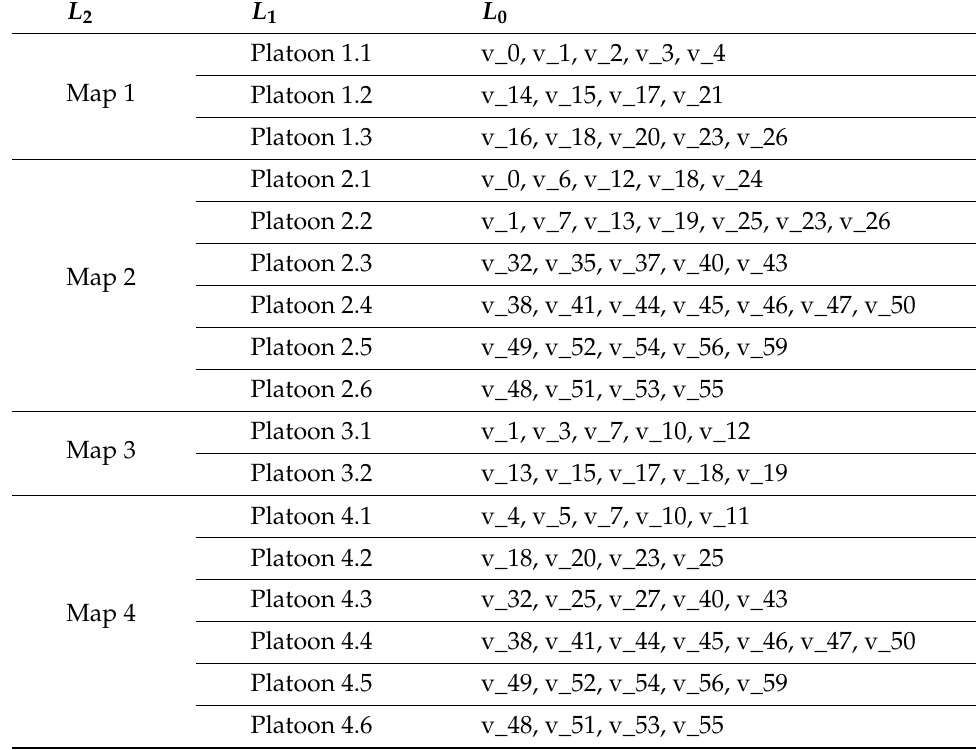
Table 3. Cluster division using the entities from the